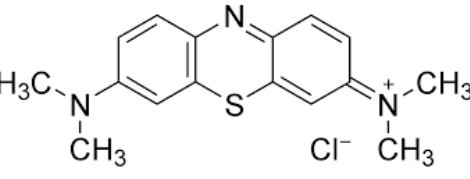
Scheme 1. Molecular structure of MB.